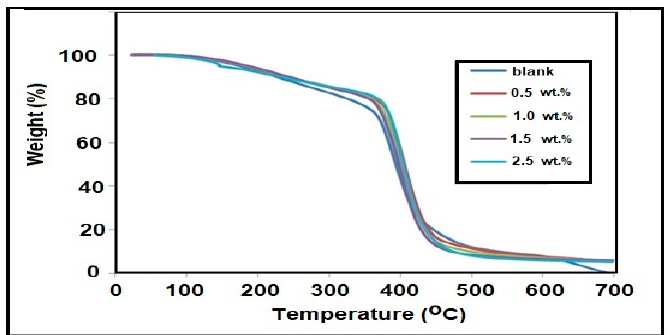
Figure 5. Thermogravimetric curves of blank epoxy and ZrO 2 /Cr 2 O 3 epoxy nanocomposites coating films containing different loading level of ZrO 2 /Cr 2 O 3 NPs.